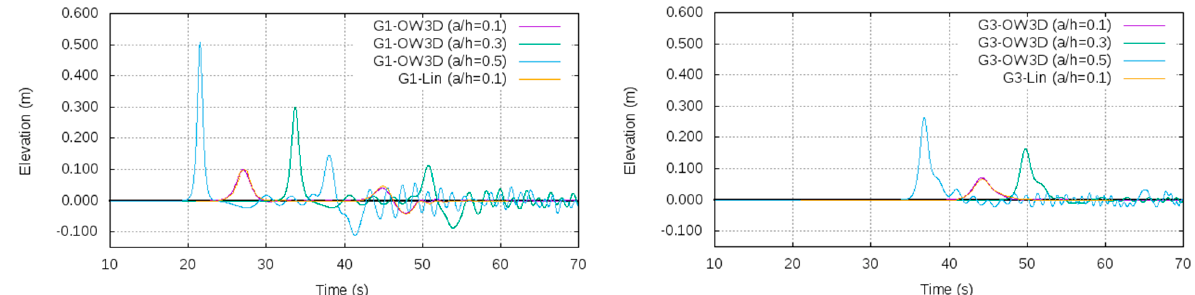
Figure 14. Relative comparison among the wave gauge results from the CFD simulations (coupled OF and OW3D model) for gauge G1 ( left ) and G3 ( right ) at a / h = 0.1, 0.3, and 0.5, and the results from [31] at a/h = 0.1.